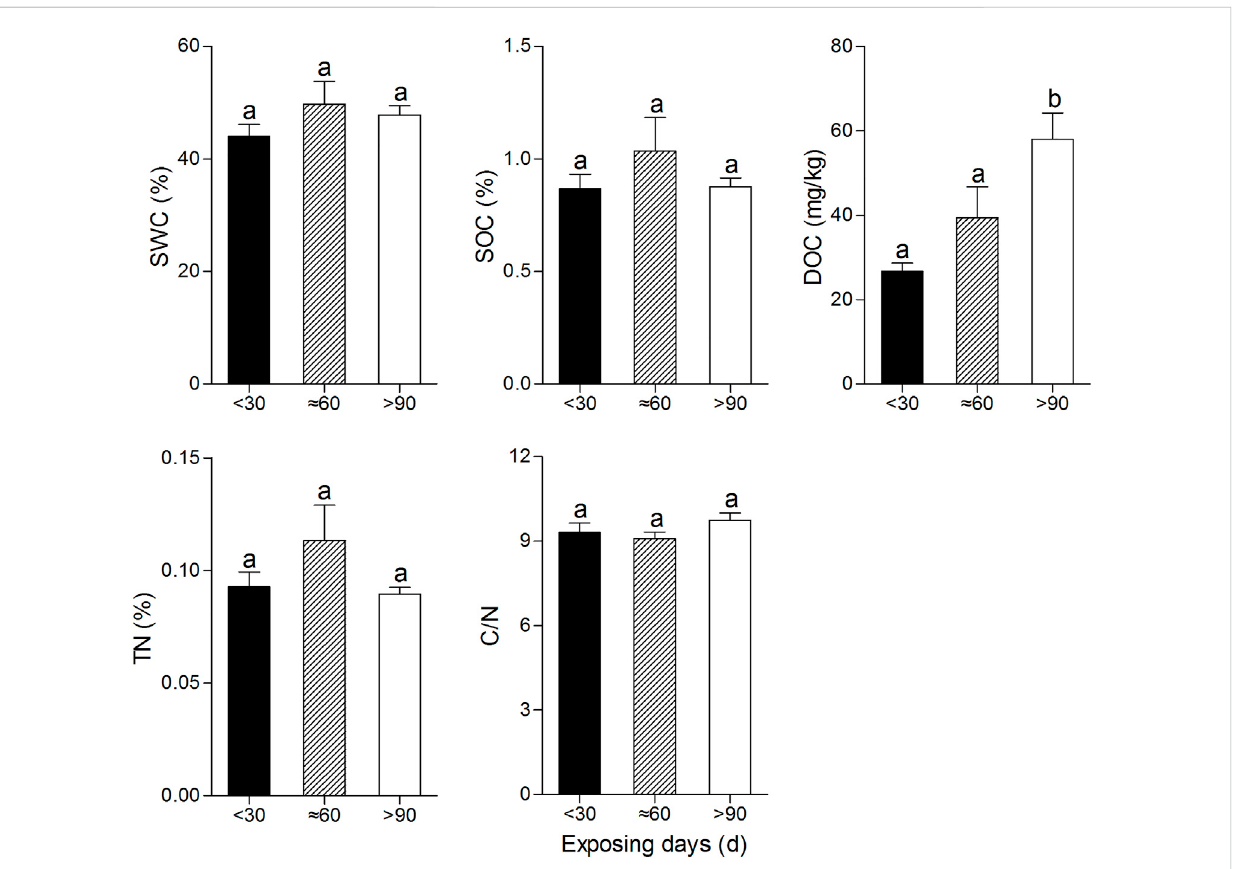
FIGURE 3 Soil properties at 3 categories of CDE. The values of each soil property with the same lowercase letter do not differ signi fi cantly ( p > 0.05) based on Dunn ’ s multiple comparison test.